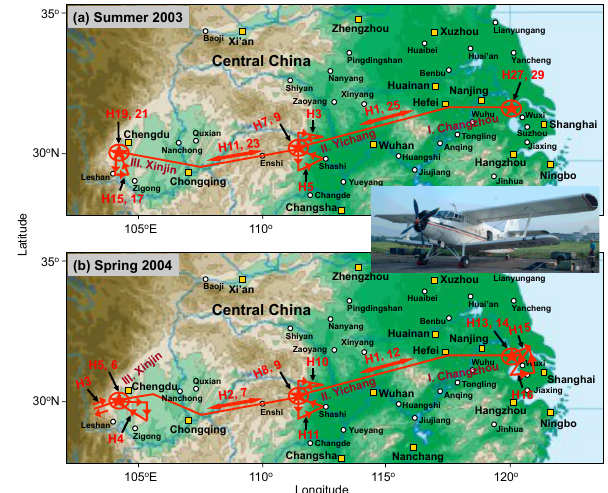
Fig. 1. Flight tracks during (a) late summer of 2003 (8 August– 13 September) and (b) late spring of 2004 (19 May–10 June) over central East to West China. The hovering flights (H7, 9, H19, 21, and H27, 29 in (a) , and H5, 6, H8, 9, and H13, 14 in b ) over local cities were named as O-shaped flight and shown as circles. Flights H3, H5, and H15,17 in (a) , and flights H3, H4, H10, H11, H15, and H16 in (b) were also designed for local cities (named as L- shaped flight). Capital cities with populations more than 1 million are shown in yellow